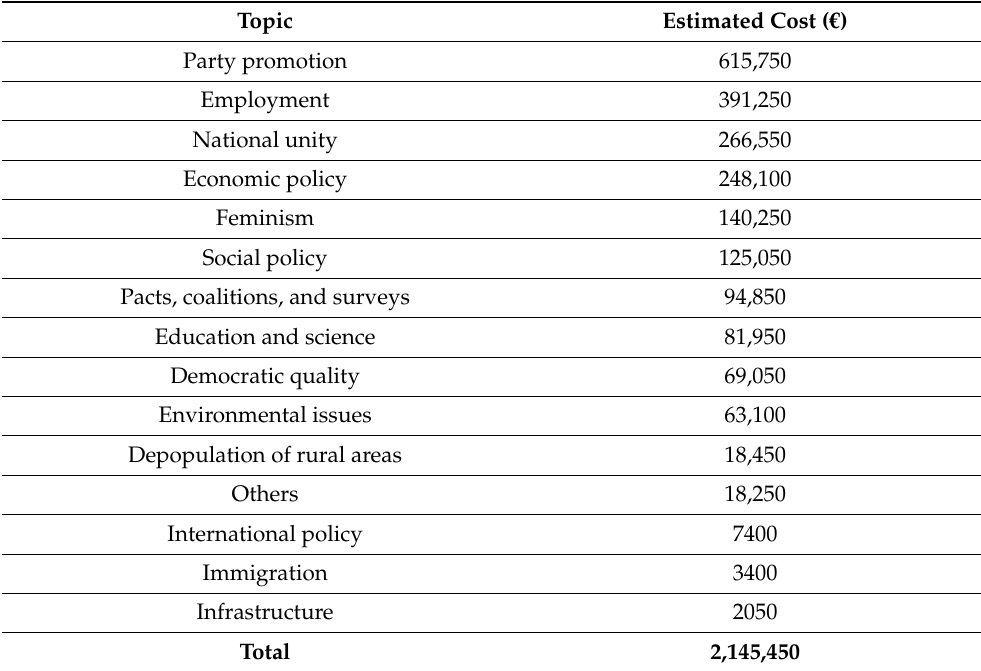
Table 3. Estimated cost by topic of the Facebook ads published by the six Spanish parties in both 2019 election campaigns ( n = 14,695). Source: Own elaboration.